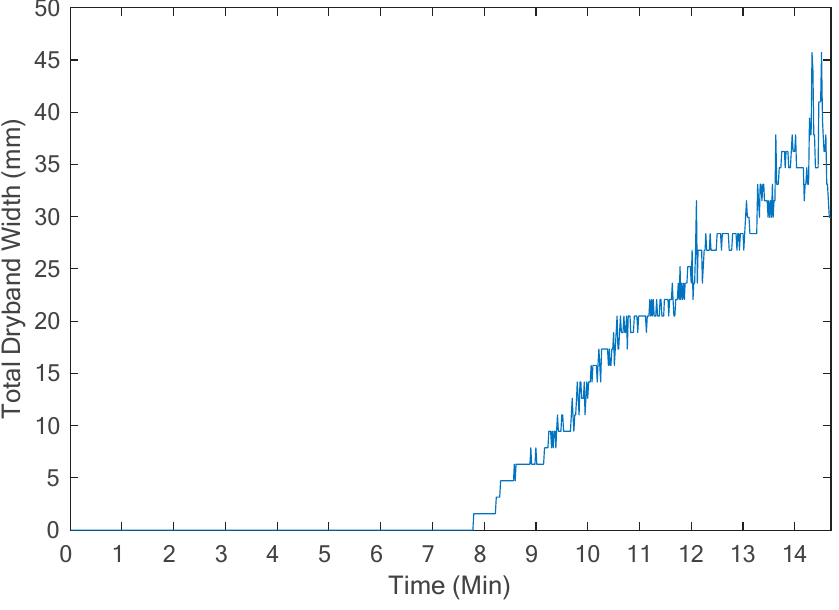
Figure A4. 3D representation of dry-band development on each trunk. Ramp-test: Design CONV, ESDD = 0.42 mg/cm 2 , and a fog rate of 3 L/hr. References 1.